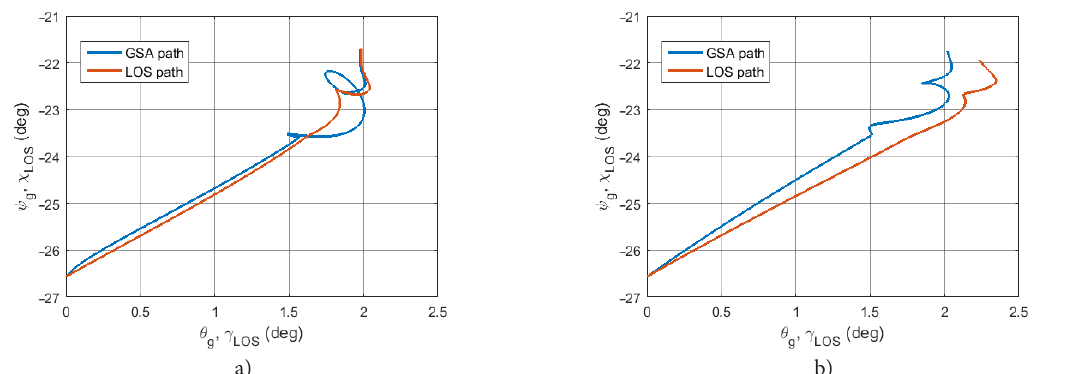
Figure 12. Actual and desired gyroscope system axis trajectories, for: a) LQR, b) PD